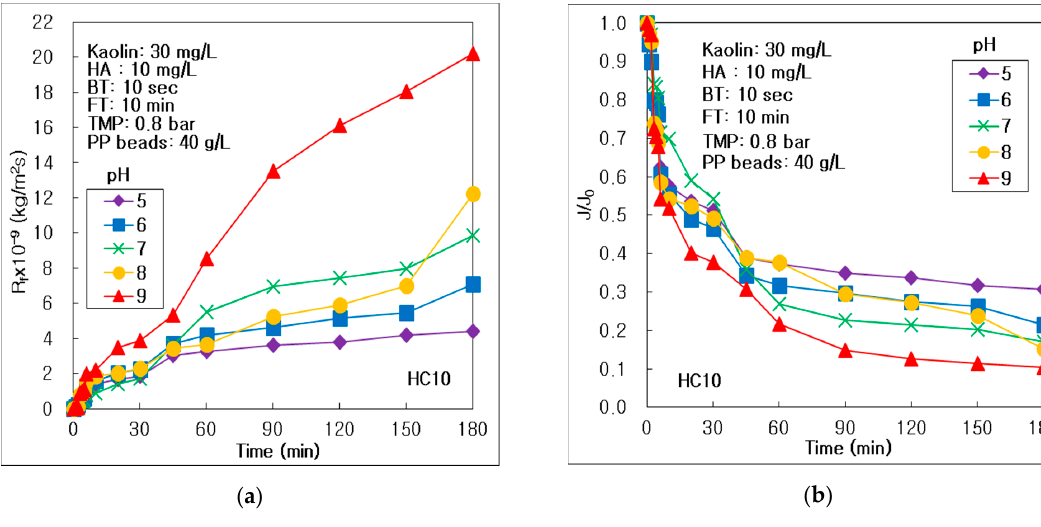
Figure 4. Effect of pH on the hybrid process of multichannel alumina MF and PP beads with UV irradiation and periodic water backwashing: ( a ) Resistance of membrane fouling and ( b ) dimensionless permeate flux.